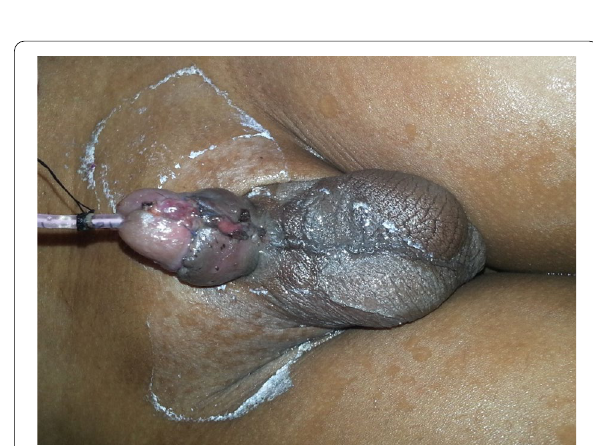
Fig. 6 Appearance at the time of dressing on 4th postoperative day